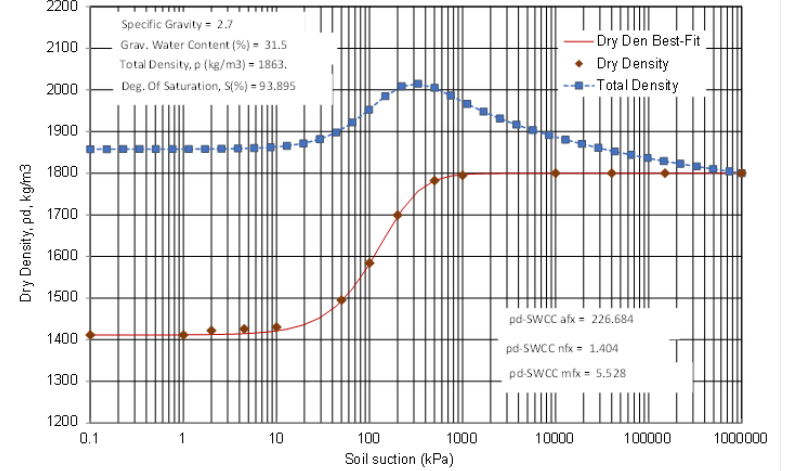
Figure 18. Dry density and total density versus soil suction for the test data presented. Soil suction for the desorption range ( ρ d -SWCC).